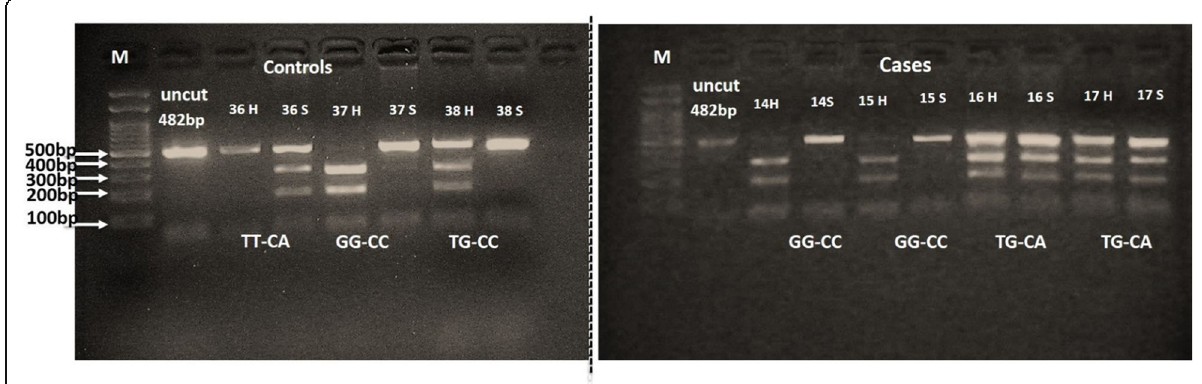
Fig. 1 Two separate PCR-RFLP 2%gel electrophoresis results for cases and controls. M : 100 bp molecular marker, 482 bp represents the uncut PCR product. Each case or control has two results depending on the different restriction enzymes used; H : HaeIII that cuts at 1S polymorphic site thus: homozygous wild type TT gets no cut fragments as in sample 36; while homozygous GG genotype gets two fragments (297, 185 bp) as in samples 37, 14, 15, whereas heterozygous TG gets three fragments (482,297,185) as in samples 38, 16, and 17. S : StyI which cleaves at 2 polymorphic sites as a result homozygous wild type CC gets no cut fragments as in samples 37, 38, 14, and 15. While heterozygous CA gets three fragments (482,308, and 174 bp) as in samples 36, 16, and